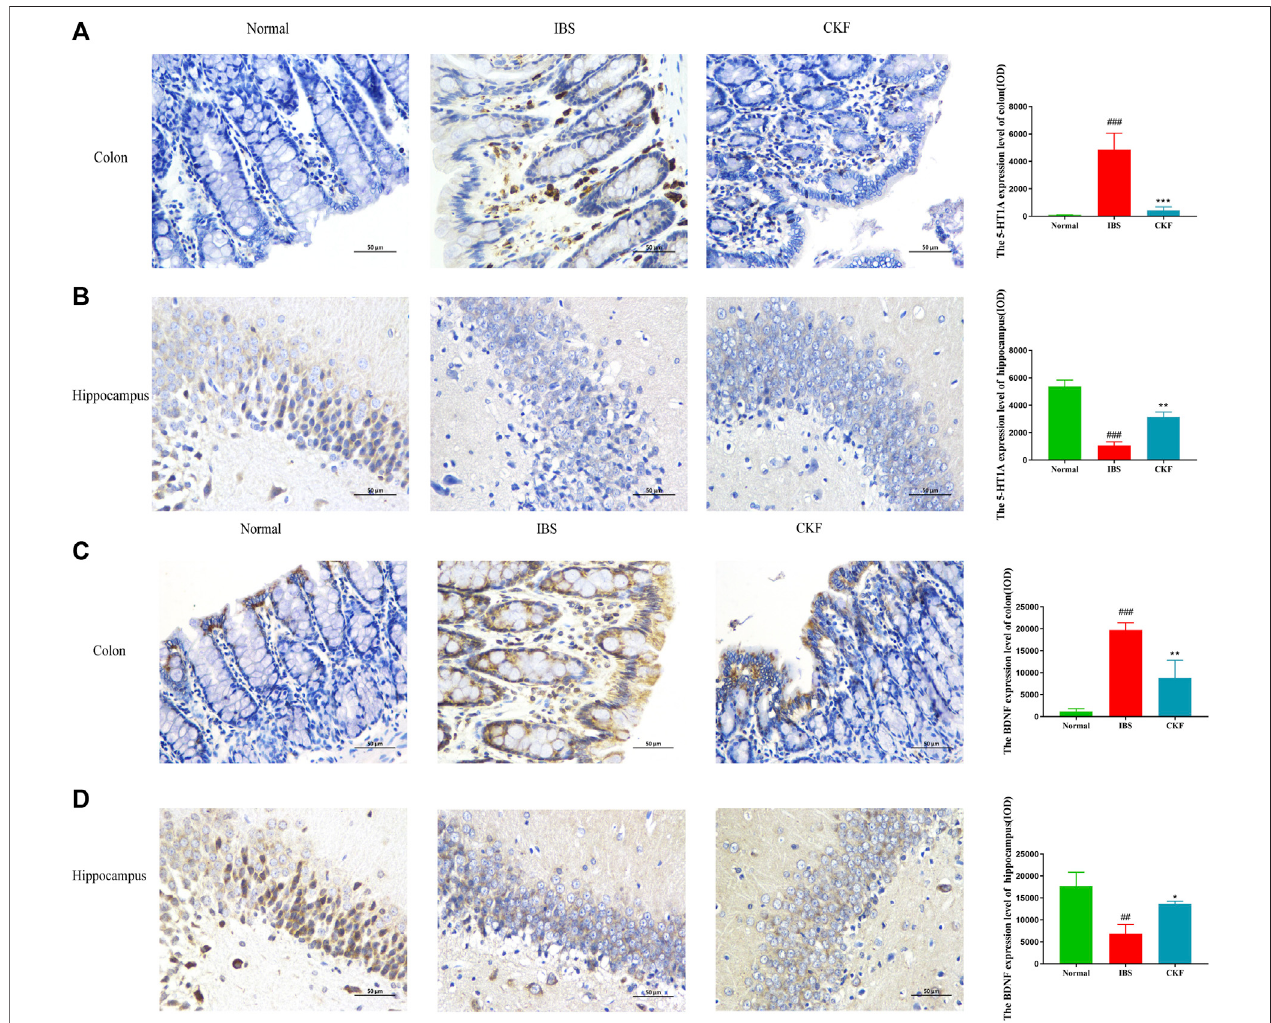
FIGURE5| Immunohistochemicalstaininginthecolonand hippocampal (A,B) 5-HT1ARand (C,D) BDNF. Valuesarepresented asthemeans±SD( n =3). ### p < 0.001 compared to Normal,* p < 0.05, ** p < 0.01 and *** p < 0.001 compared to IBS.